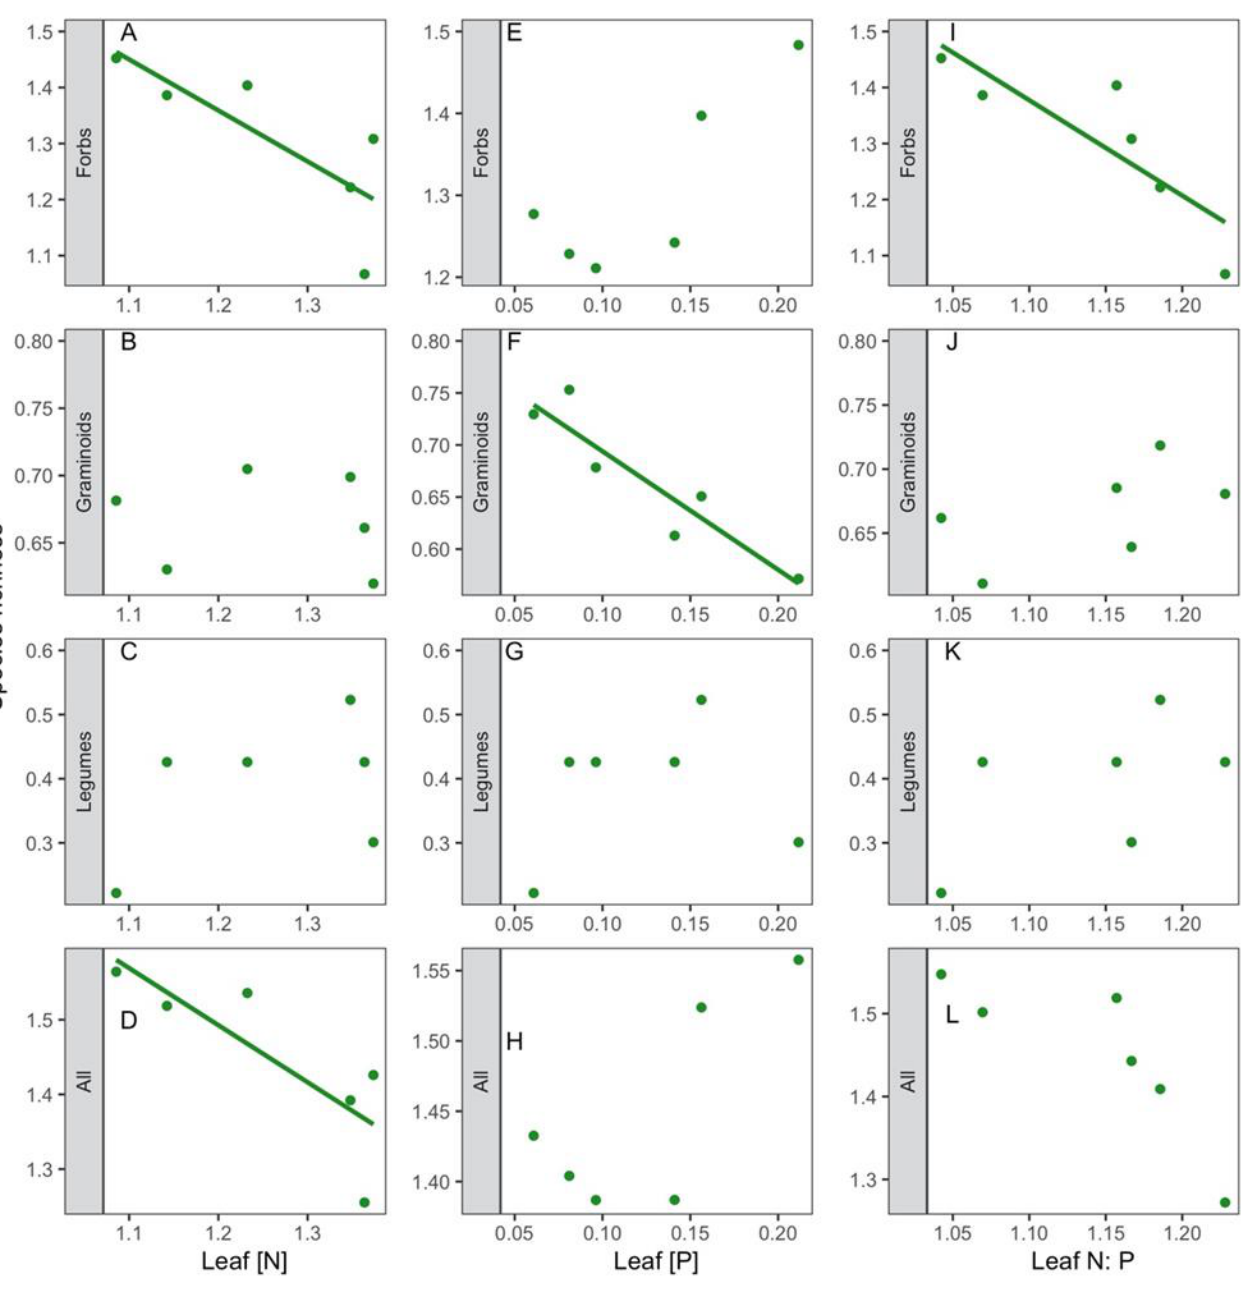
Figure 5. Correlations of species richness of each plant functional group and the whole community with leaf N concentration ( A – D ), with leaf P concentration ( E – H ), and with leaf N:P ratio ( I – L ). Variables are log10-transformed.